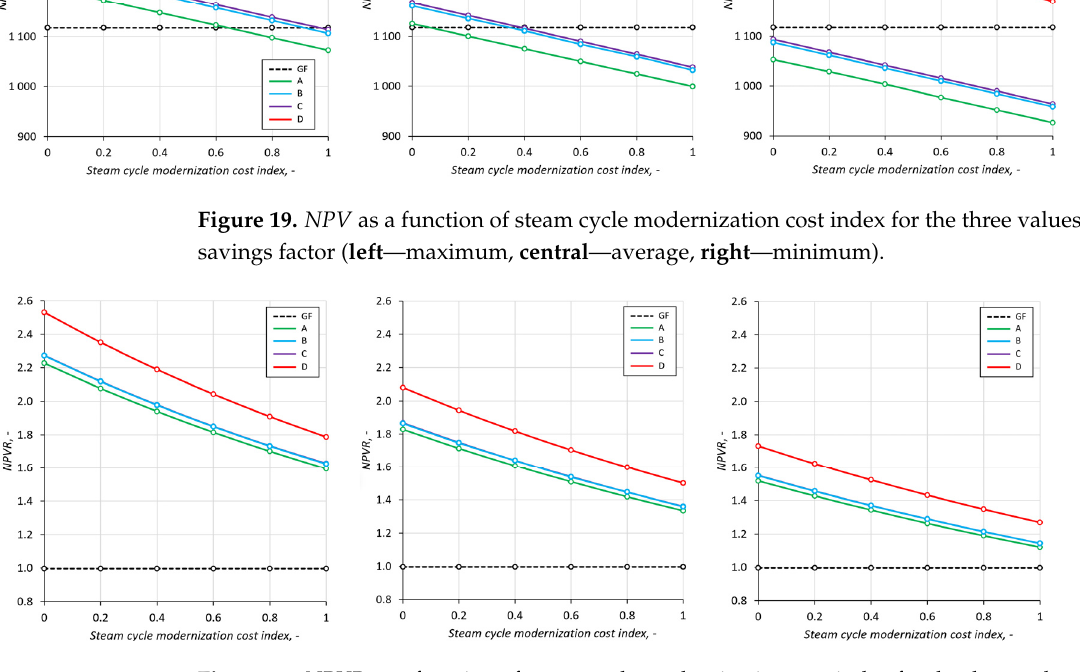
Figure 20. NPVR as a function of steam cycle modernization cost index for the three values of retrofit savings factor ( left —maximum, central —average, right —minimum).